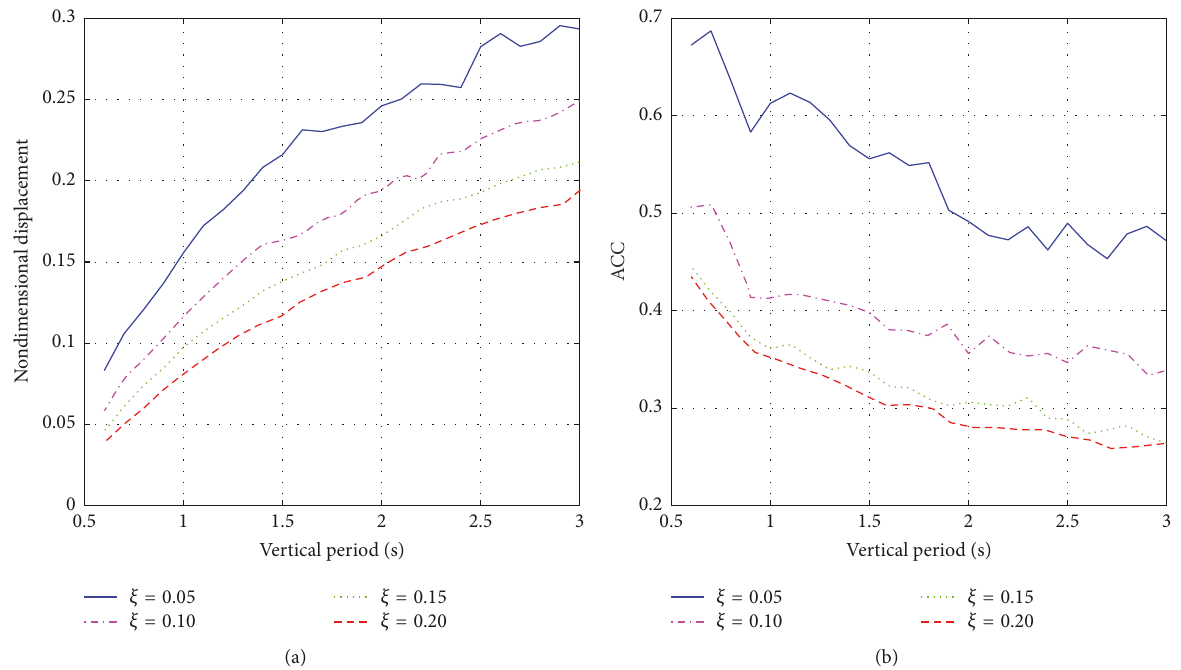
Figure 10: Comparison of AAC for a seismic isolated structure with QZS ( ℎ 0 = 0.1